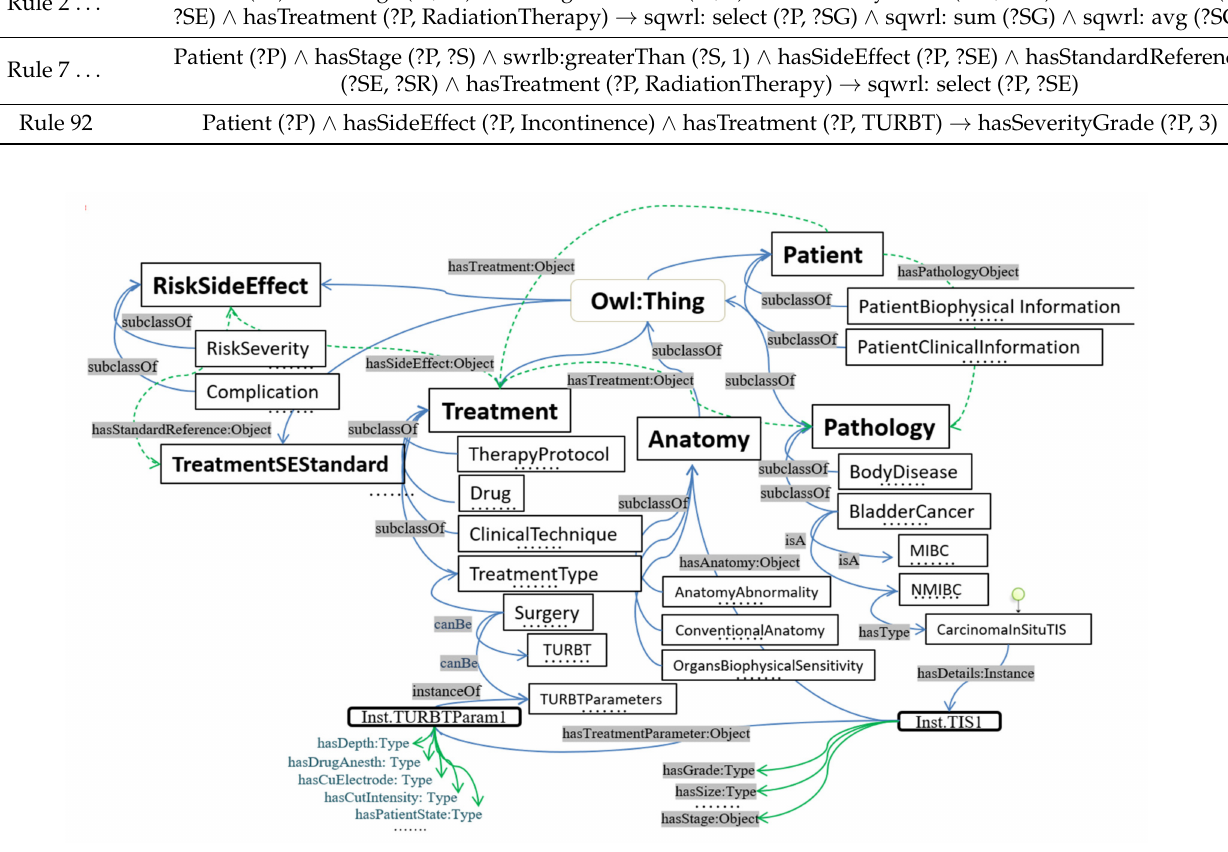
Figure 10. Conceptual knowledge model of our bladder cancer treatment side effects